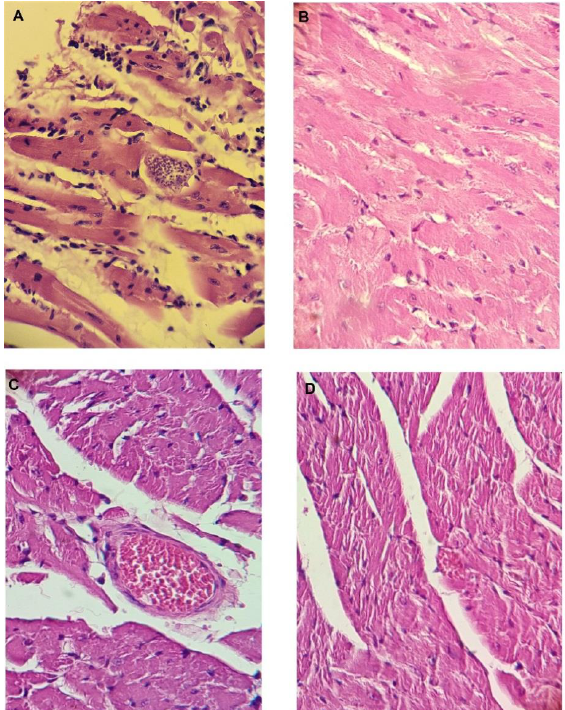
Figure 5. Heart tissue sections of animals infected with Trypanosoma cruzi : ( A ) untreated animals, the black arrow indicates the amastigote’s nests. ( B ) Animals treated with combination 793 + 1018 (according to doses shown in ( A )). ( C ) Animals treated with combination 793 + 1019 (according to doses shown in ( B )). ( D ) Animals treated with Bnz . Hematoxylin – eosin staining, 40X magnifica- tion.